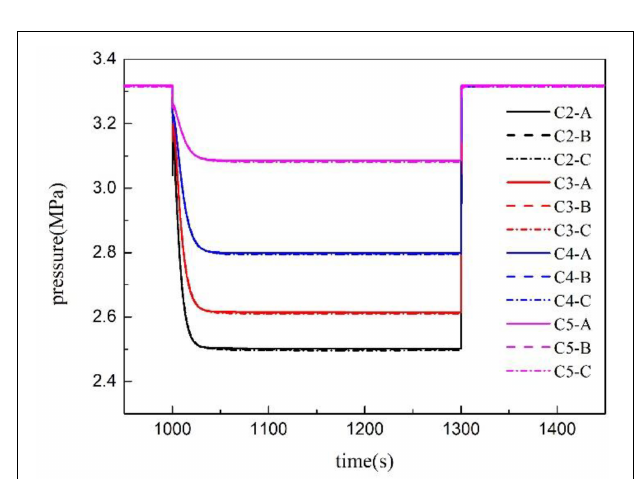
FIGURE 10 | Pressure of each pressure measuring